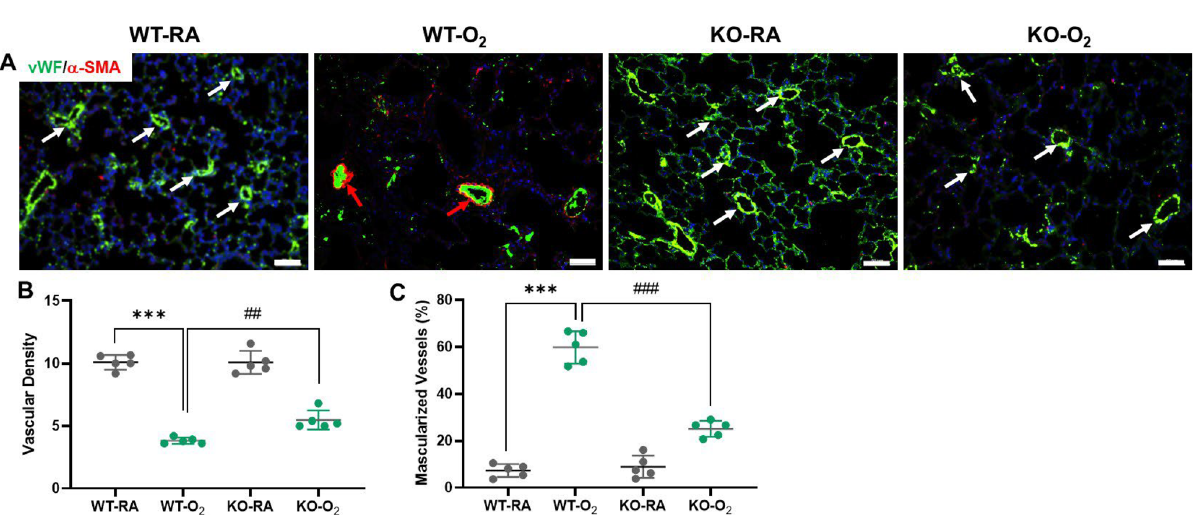
Figure 3. GSDMD-KO improves vascularization and reduces vascular remodeling in hyperoxia-exposed lungs. ( A ) Lung vascularization and vascular remodeling were assessed by double Immunofluorescence for vWF (an endothelial marker, green stain, white arrows), α-SMA (a smooth muscle marker, red stain, red arrows), and DAPI nuclear staining (blue stain). ( B ) Vascular densities (vessels < 50 μm) were decreased in WT-O 2 lungs but increased in KO-O 2 lungs compared to the WT-O 2 group. ( C ) Muscularized vessels (> 50% circumference staining for α-SMA) were increased in WT-O 2 lungs but less in KO-O 2 lungs. n = 5/groups. *** P < 0.001, WT-RA vs WT-O 2 . ## P < 0.01, ### P < 0.001, WT-O 2 vs KO-O 2. 20 × magnification. Scale bars: 50